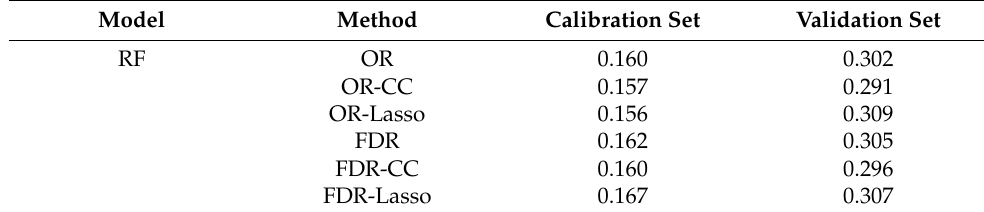
Table 6. Results of the RF model stability index calculation. Model